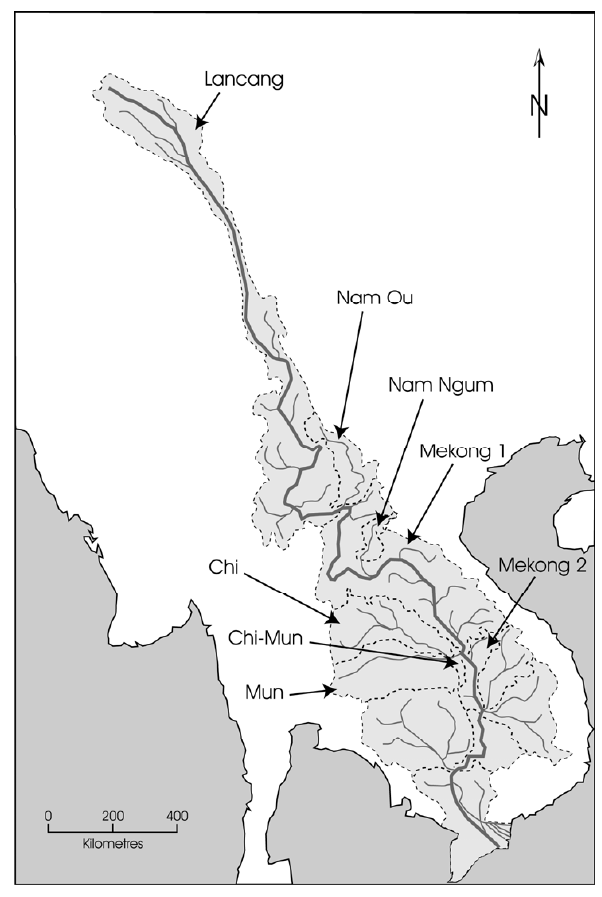
Fig. 1. The Mekong River Basin and sub-basins defined by Kite (2001). Note: only the sub-basins modelled in the current study are